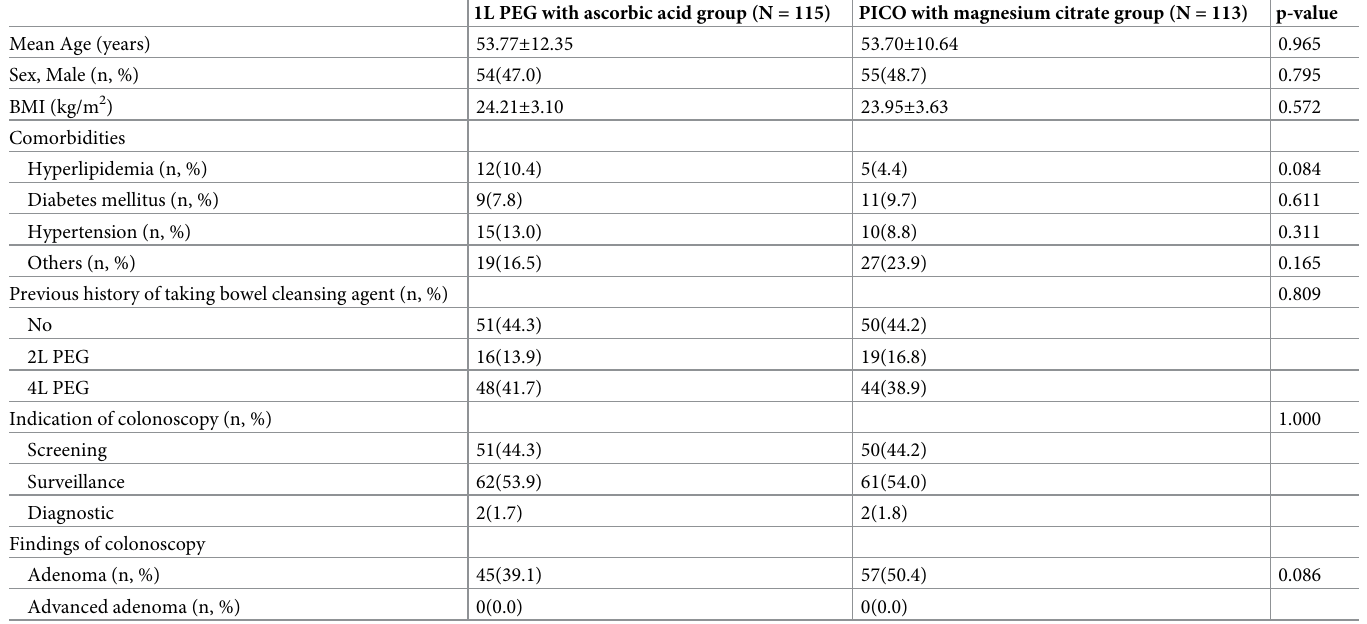
Table 2. Baseline characteristics of the patients according to bowel cleansing agent.